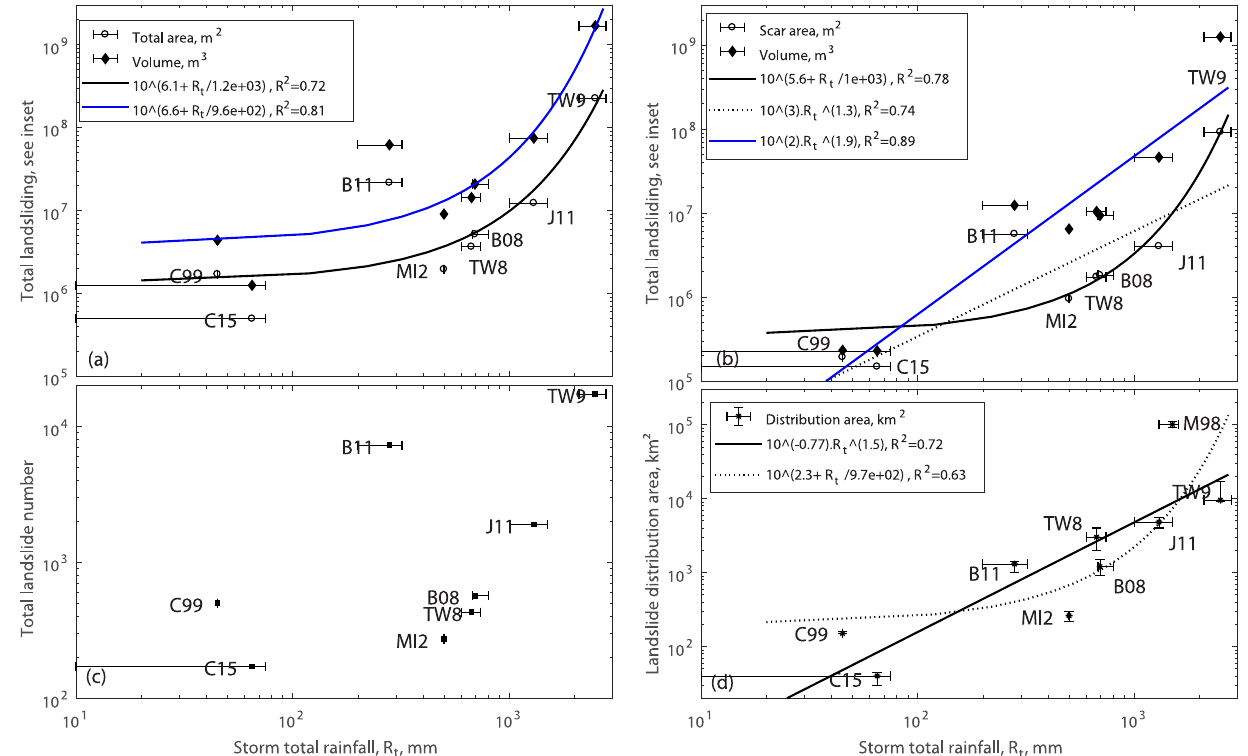
Figure 5. Total landsliding in area and volume derived from whole landslides (a) or from scar estimates only (b) , total landslide number (c) and landslide distribution area (d) against storm total rainfall. M98 is for Mitch 1998. Horizontal error bars show a range of maximum storm rainfall when available (cf., Table 1). In (a) and (b) 1 σ uncertainty in the total volumes and areas, ignoring potential landslide mis-detections (cf. methods), are smaller than the symbols ( < 10%). Vertical error bars are based on the range of affected areas in (d) , while we could not obtain quantitative uncertainties in the total number (c)